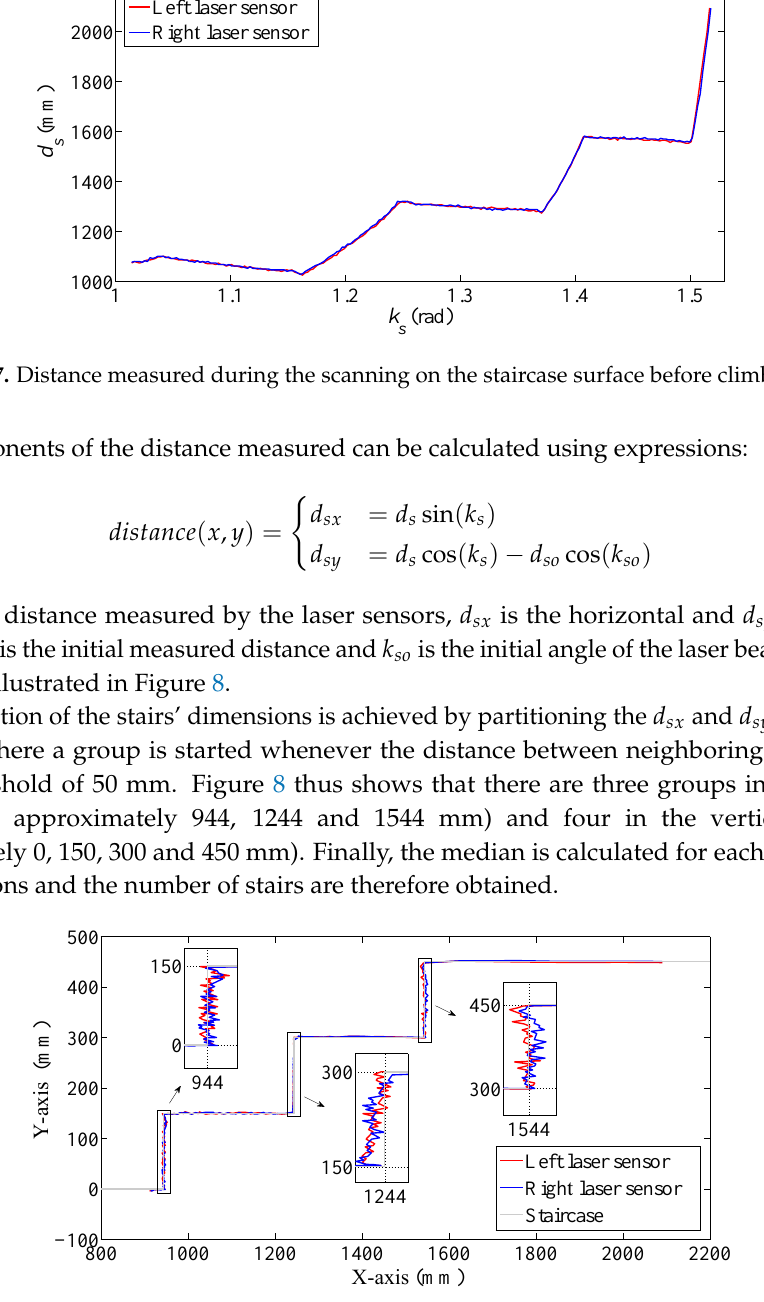
Figure 8. Estimated shape and size of the